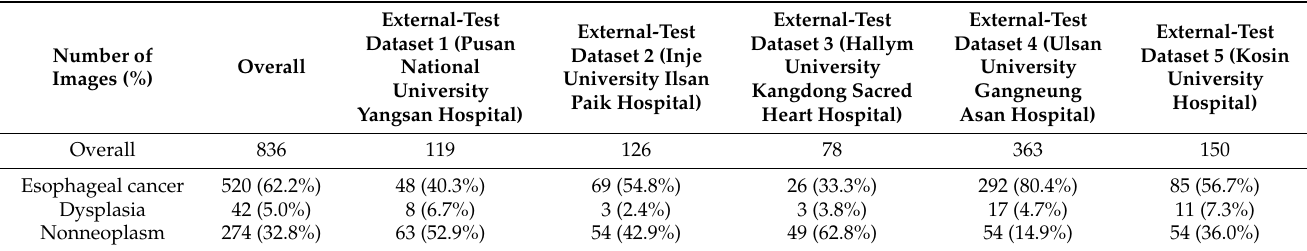
Table 2. Distribution of the collected images for the external-test